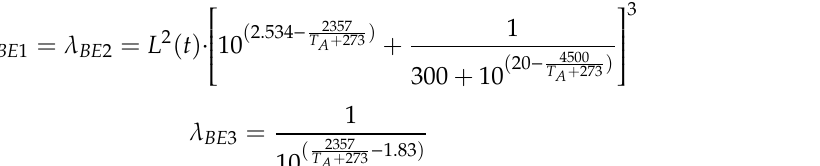
Failure Rate (MIL-HDBK-217) BE1/BE2